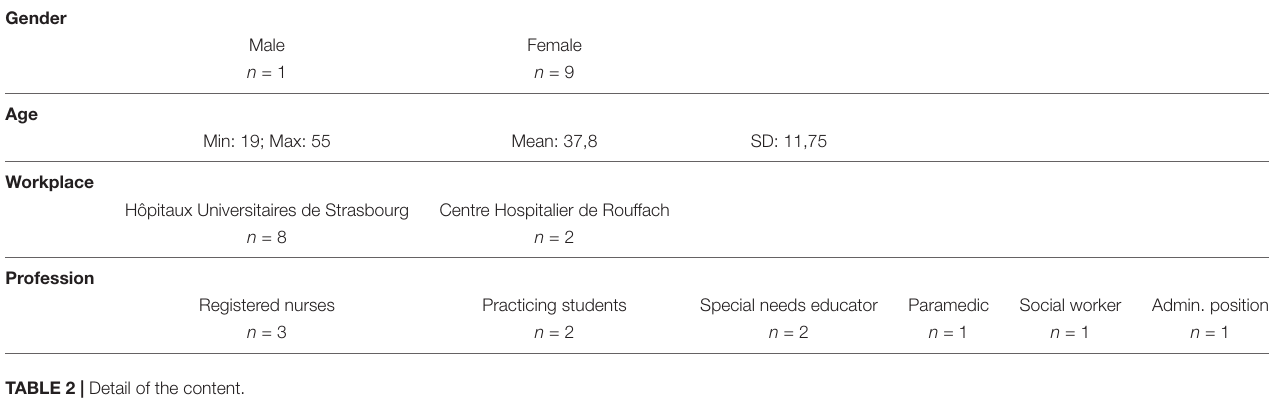
TABLE 1 | Participants demographic table.